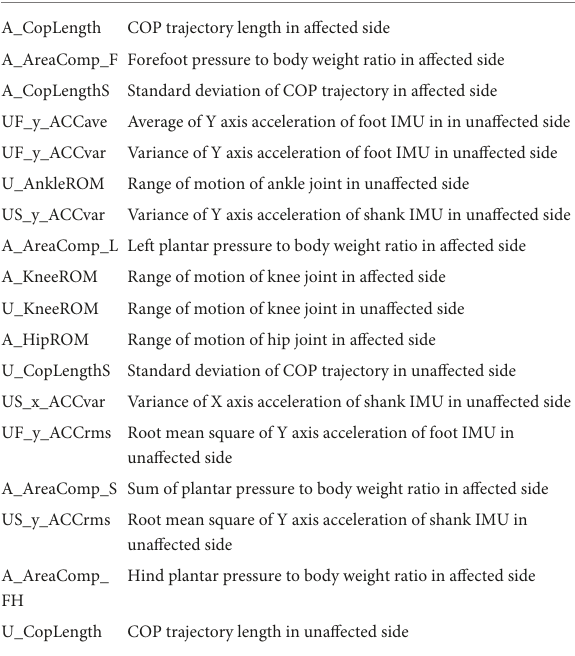
TABLE 3 Definition of features in Figure 5